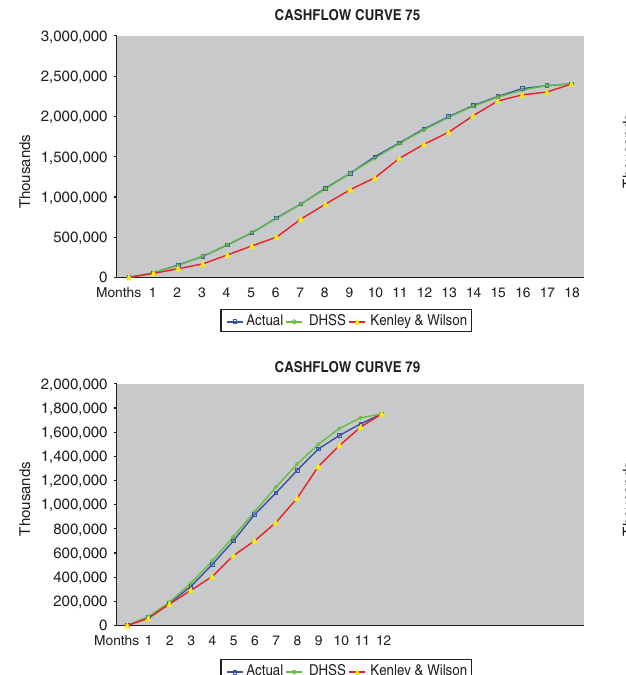
Fig. 4. Cash fl ow curves for projects 75, 76, 79 and 80